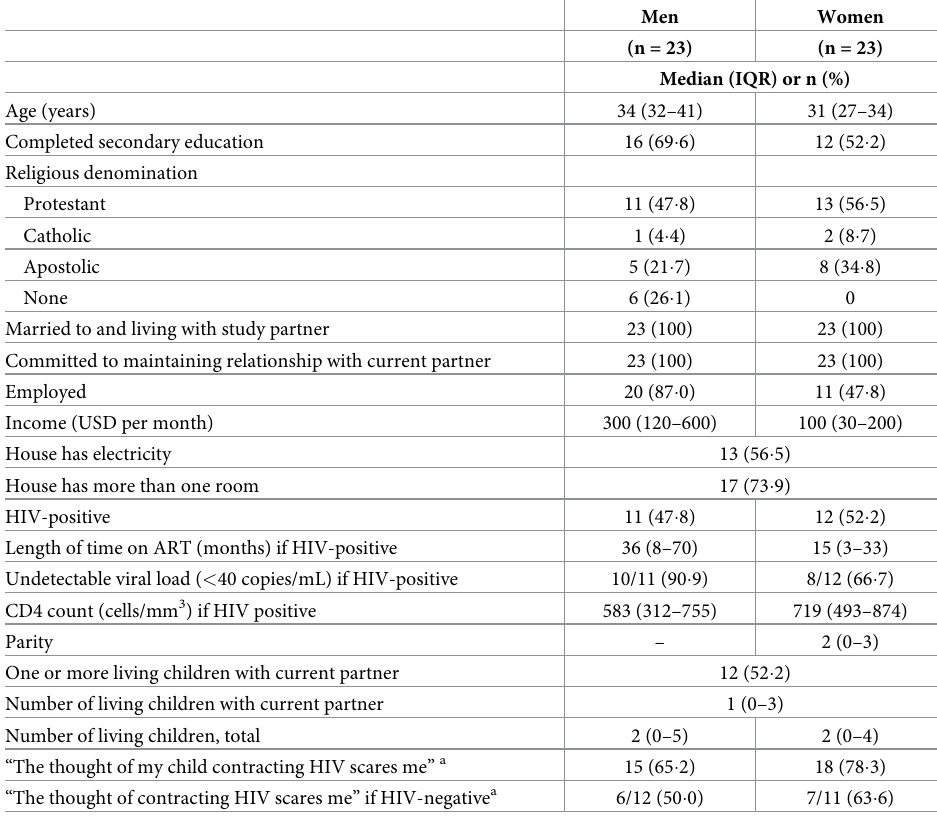
Table 1. Baseline characteristics of enrolled